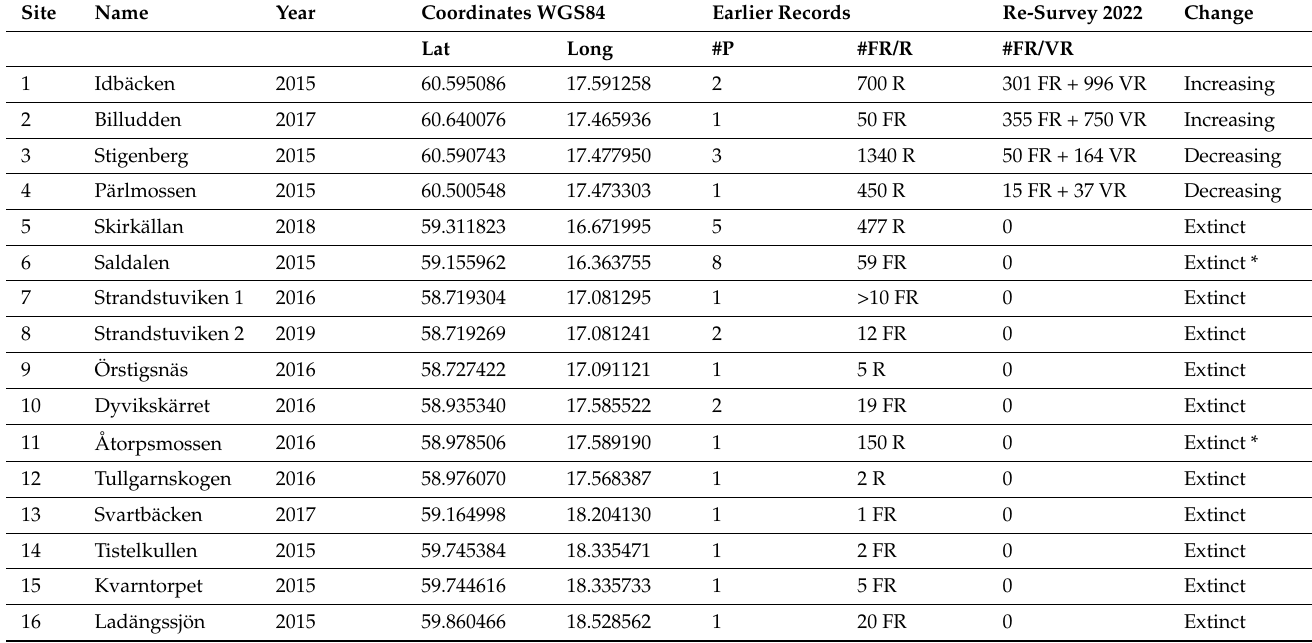
Table A2. Results from a re-survey conducted in 2022 of Moneses uniflora